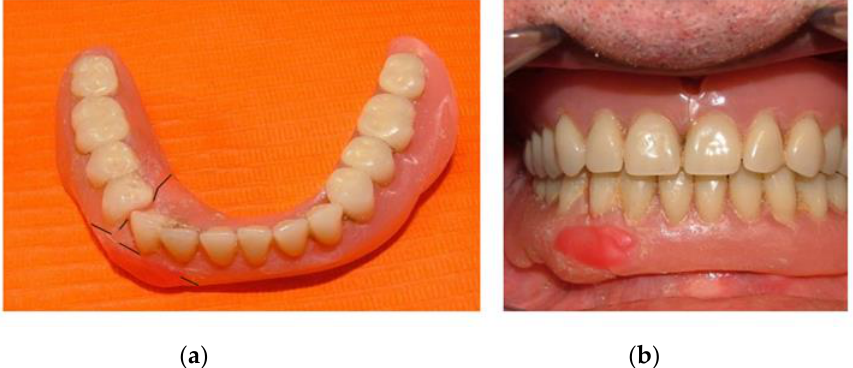
Figure 3. ( a ) Patient ’ s prosthesis reassembly; ( b ) evaluation of the occlusion, in which the fracture of the upper prosthesis is noted.